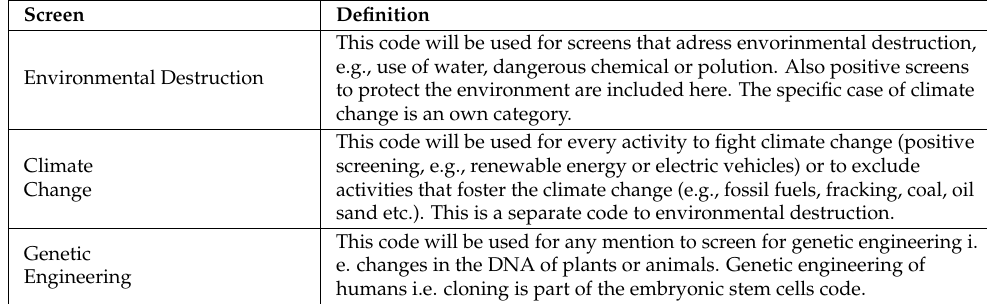
Table A2. Definition of Investment